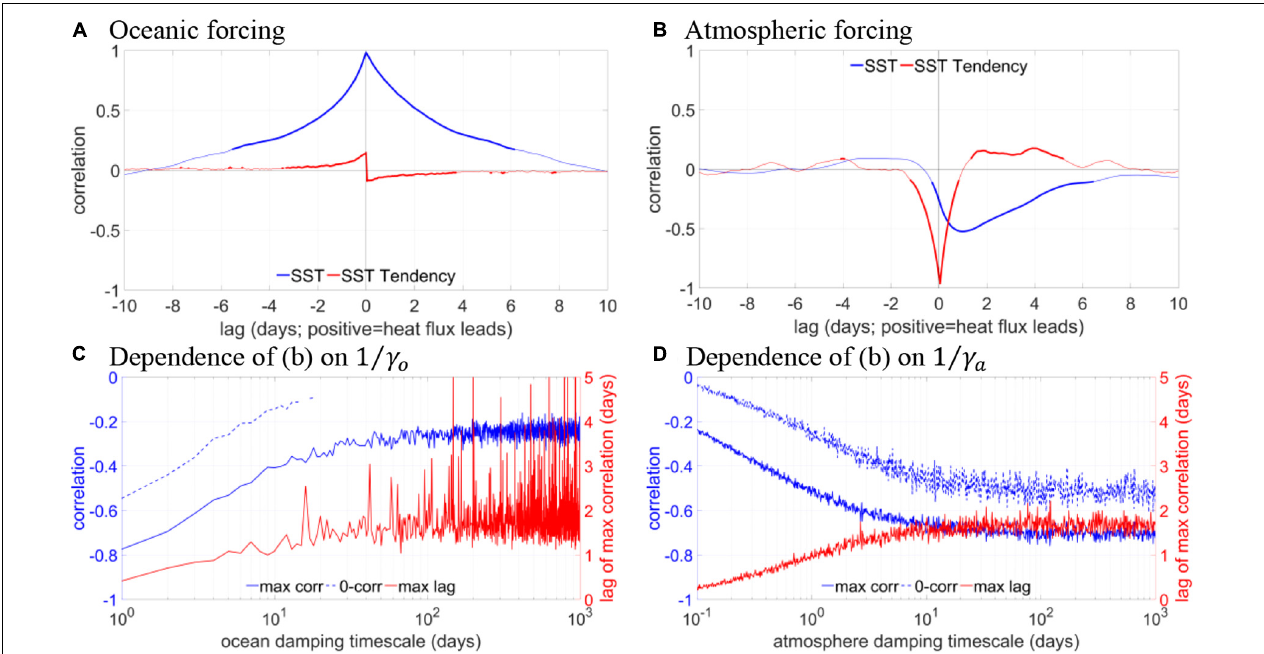
FIGURE 3 | (A) Cross-correlation of heat flux with SST and SST tendency in the pure oceanic forcing case of the theoretical model. Here α = 1/2 d − 1 , β = 1/5 d − 1 , γ a = 1 d − 1 , γ o = 1/5 d − 1 , ω a = 0, ω o = 1/10 d − 1 . Thick parts of the curves indicate statistical significance at the 95% level. (B) Same as (A) but for the pure atmospheric forcing case. Here ω a = 1 d − 1 , ω o = 0, and other parameters are the same as in (A) . (C) Dependence of (B) on ocean damping timescale 1 / γ o in terms of simultaneous correlation, maximum correlation, and time lag of maximum correlation. Only statistically significant correlation is shown. (D) Same as (C) but for dependence on atmosphere damping timescale 1 / γ a